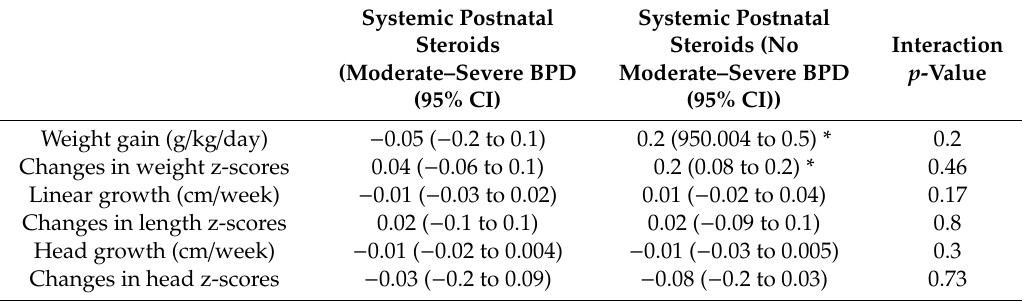
Table 4. Adjusted e ff ect of postnatal systemic steroids on the growth parameters of preterm infants < 32 weeks of gestational age at birth stratified by moderate–severe bronchopulmonary dysplasia. Regression models are adjusted by GA, sex, invasive mechanical ventilation at 28 days, length of admission, and z-score at birth (weight, length or HC). Results are adjusted associations between steroids used and growth parameters (95% CI). Changes in z-scores refer to changes in z-score from birth to